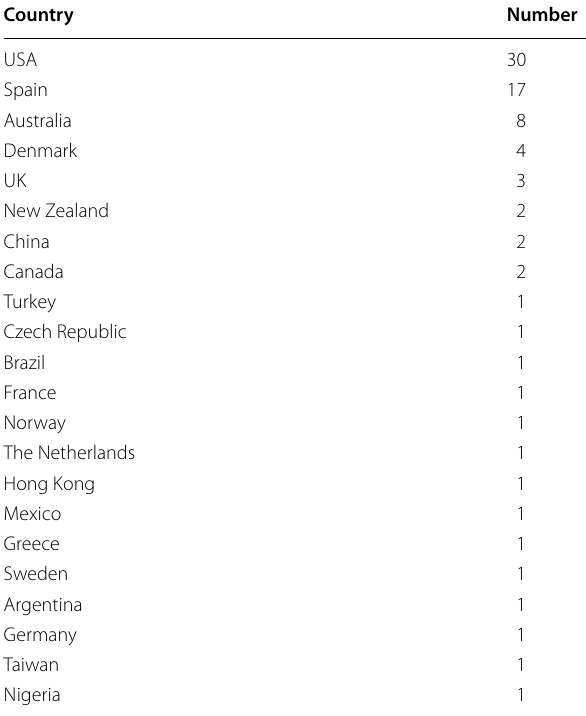
Table 1 Studies by country of